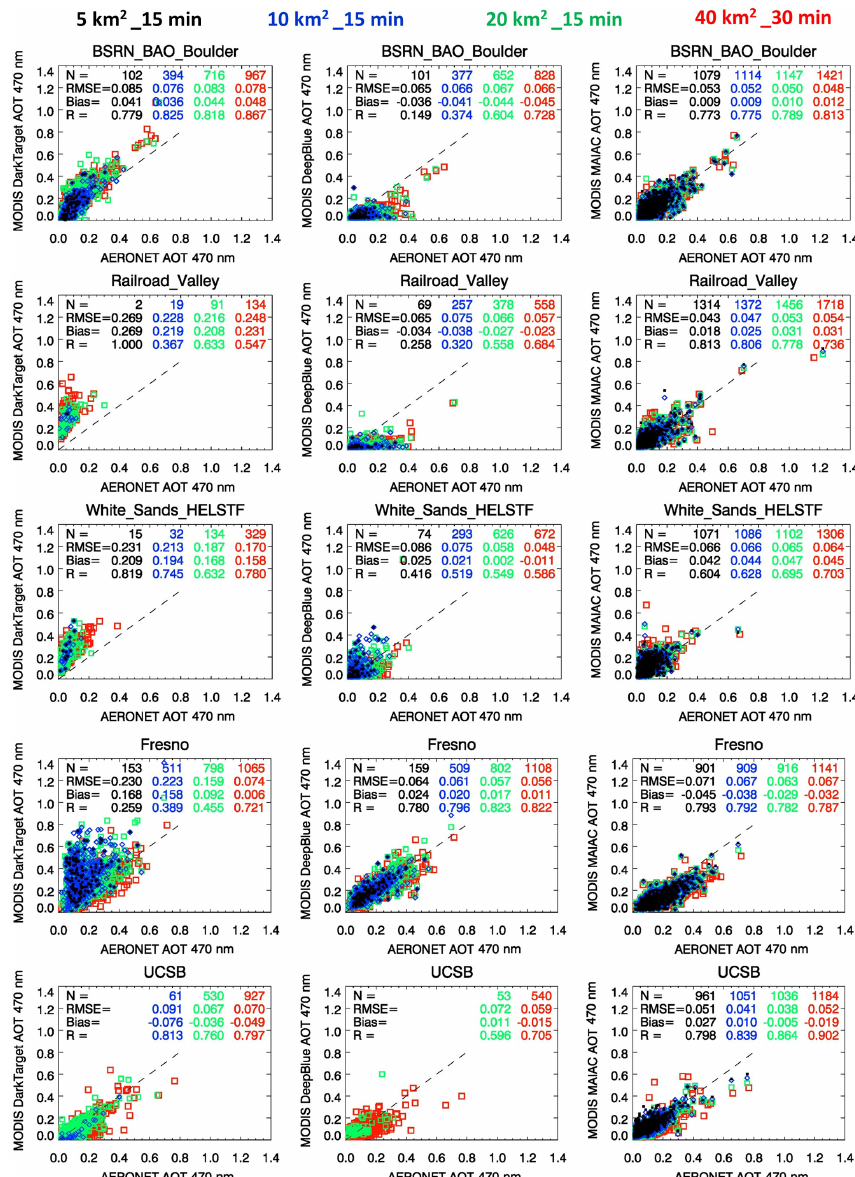
Figure 3. Same as in Fig. 3 but for AERONET sites located in the western North American